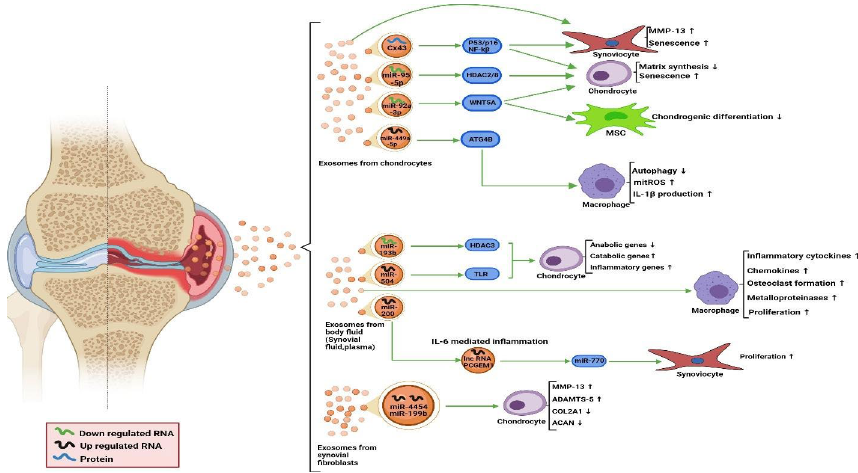
Fig. 3 Exosomes involved in pathology of different biological membranes like synovial membranes [172]. In the blood stream, exosomal packed curcumin has a longer half-life than free curcumin. Therefore, encap- sulation of the drugs in the exosomes increases the half-life of the drugs [173]. Thus, in inflammatory diseases and RA, exosomes seem to be promising transfer tools for a variety of drugs. For example, in collagen-induced arthritis (CIA) mice in which miR- 146a/miR-155 was downregulated, the miR-146a/miR-155 transduced MSC-derived exosomes significantly altered the Treg cells levels of CIA mice cell and recovered their appropriate responses [174] A similar study was done on therapeutic effect of MSC– derived miR-150-5p exosomes (Exo-150) on collagen-induced arthritis mice. The results revealed that injection of Exo-150 reduced hind paw thickness and the clinical arthritic scores in modeled mice. Moreover, Exo-150 decreased migration and invasion in RA fibroblast like synoviocytes (FLS) and downregulated tube formation in HUVECs by tar- geting MMP14 and VEGF [175].